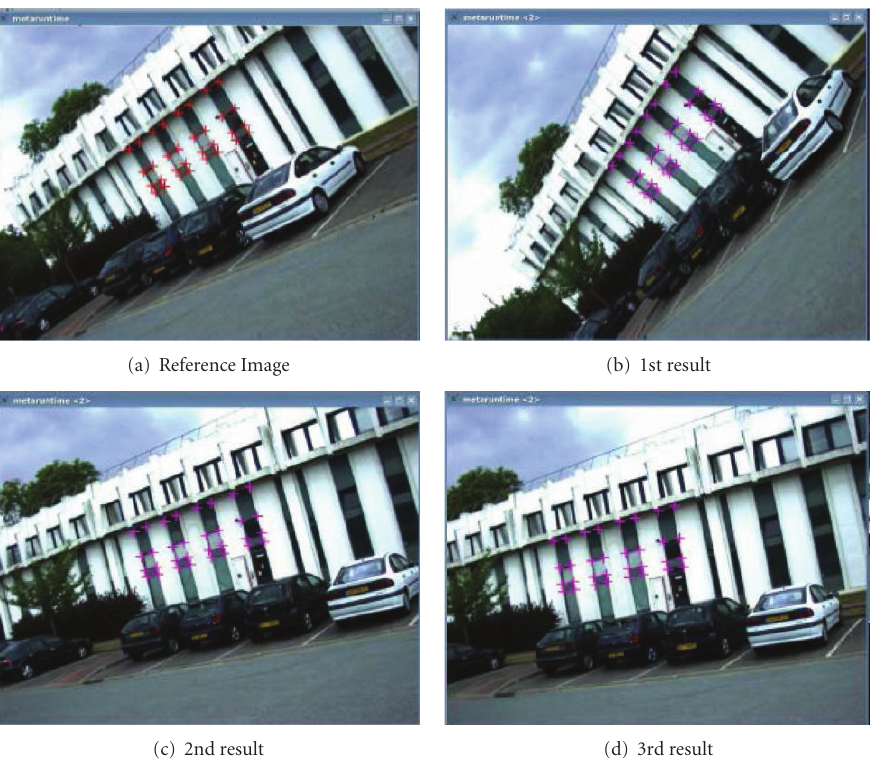
Figure 9: Matching results for autometed initialization approach, case of the coplanr points.